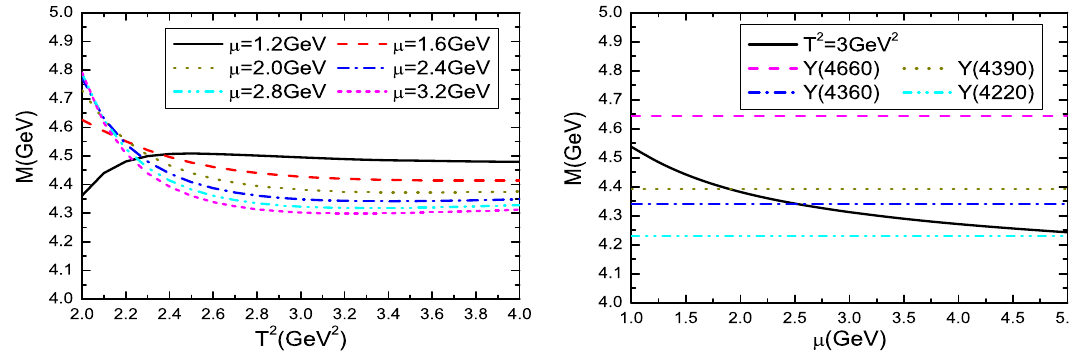
Fig. 5 The extracted mass with variations of the Borel parameters T 2 and energy scales μ